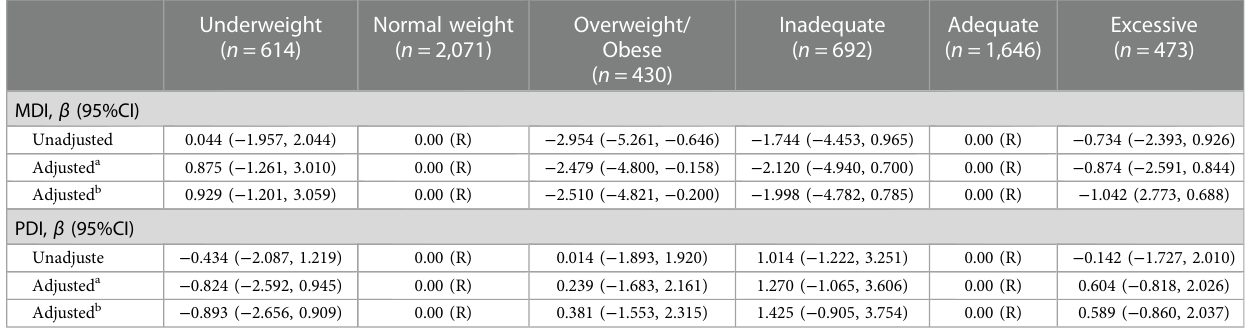
TABLE 2 Correlations among child neurodevelopment scores at age 2 and PBMI and GWG categories.